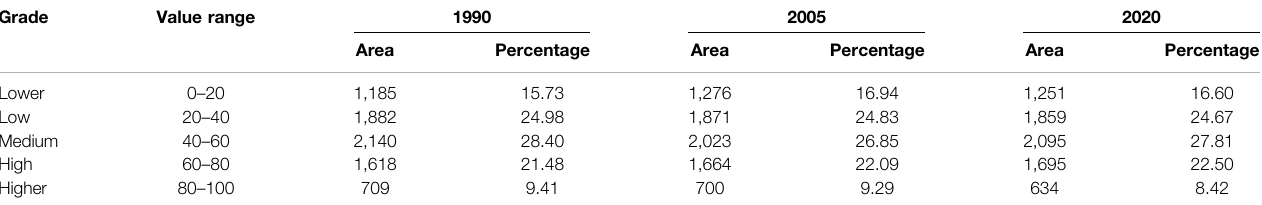
TABLE 8 | Area and percentage of ecosystem adaptation at each level.